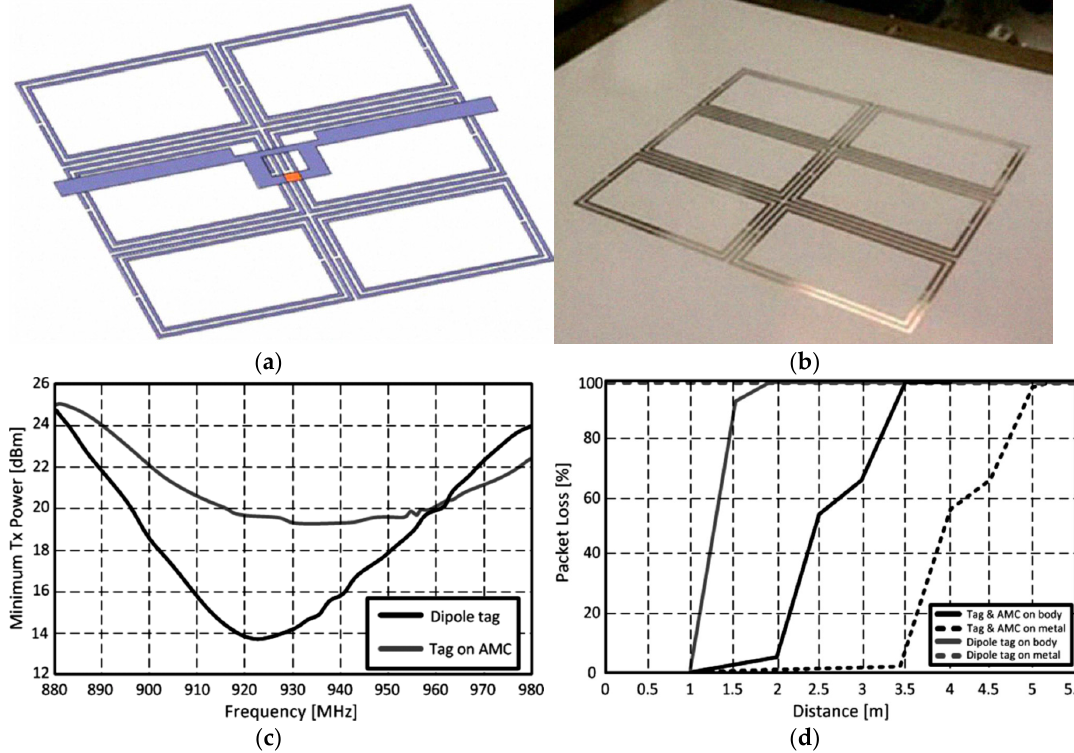
Figure 20. ( a ) Structure of the UHF dipole RFID antenna on an AMC reflector, and ( b ) the inkjet-printed split ring resonator (SRR) array. ( c ) Measured minimum Tx power required to read a tag and ( d ) tag read range.